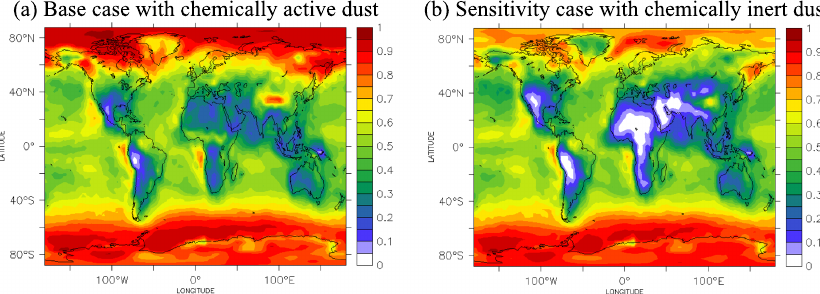
Figure 6. Predicted average near-surface fraction of total nitrate (gas plus aerosol) in the aerosol phase (a) by simulating the heterogeneous chemistry between dust and nitrate species (base case), and (b) by switching off dust chemistry (sensitivity case) during the years